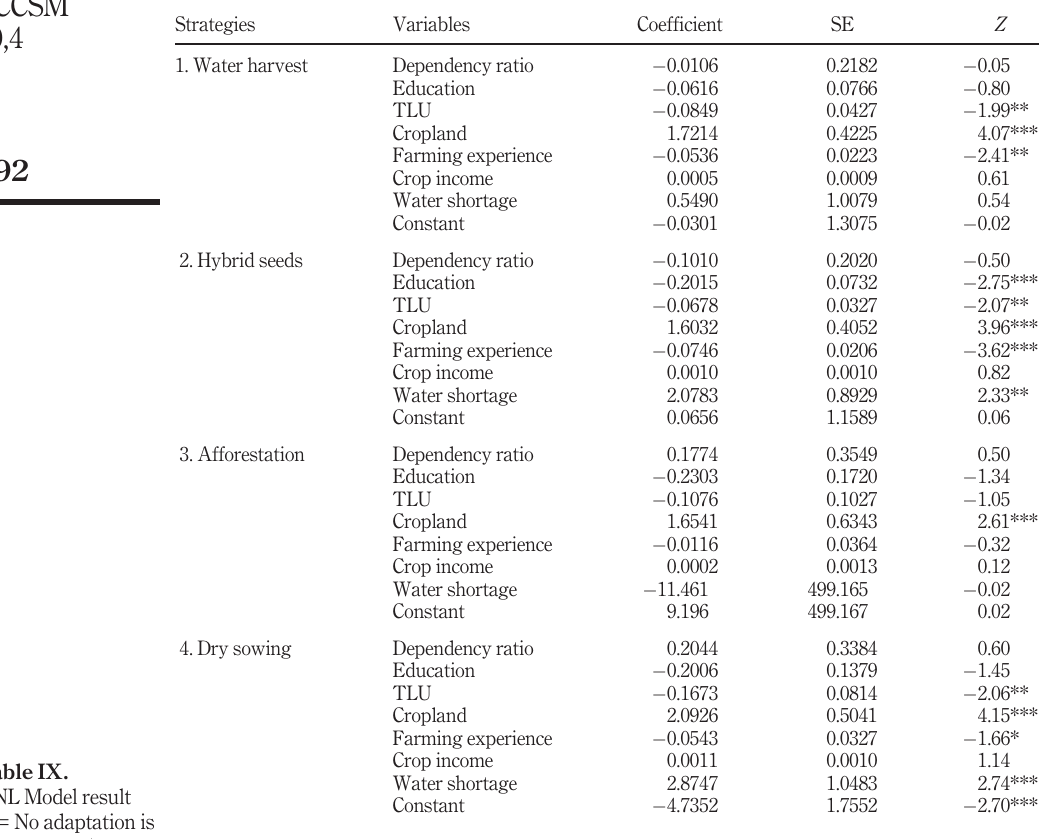
Table IX. MNL Model result (0 = No adaptation is base